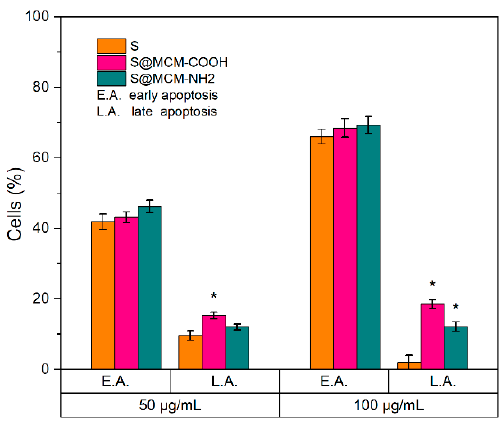
Figure 7. Flow cytometry analysis of cultured Mel-Juso cells’ mortality by apoptosis after exposure to free and embedded polyphenolic extract at 50 µg/mL and 100 µg/mL concentration for 72 h. Results are expressed as mean ± standard deviation (n = 3). * p < 0.05 compared to free extract, S (Student’s t -test).